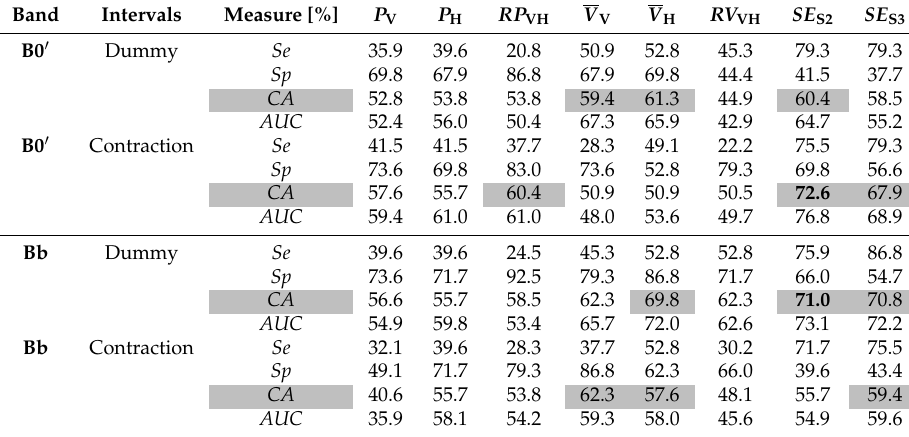
Table 5. Classification performance results obtained using individual features for preterm and term dummy and contraction intervals of the TPEHGT DS. The highest three classification accuracies, CA , per dummy or contraction interval are shaded in gray. The highest CA per frequency band is shaded in gray and in bold. The highest CA is shaded in dark